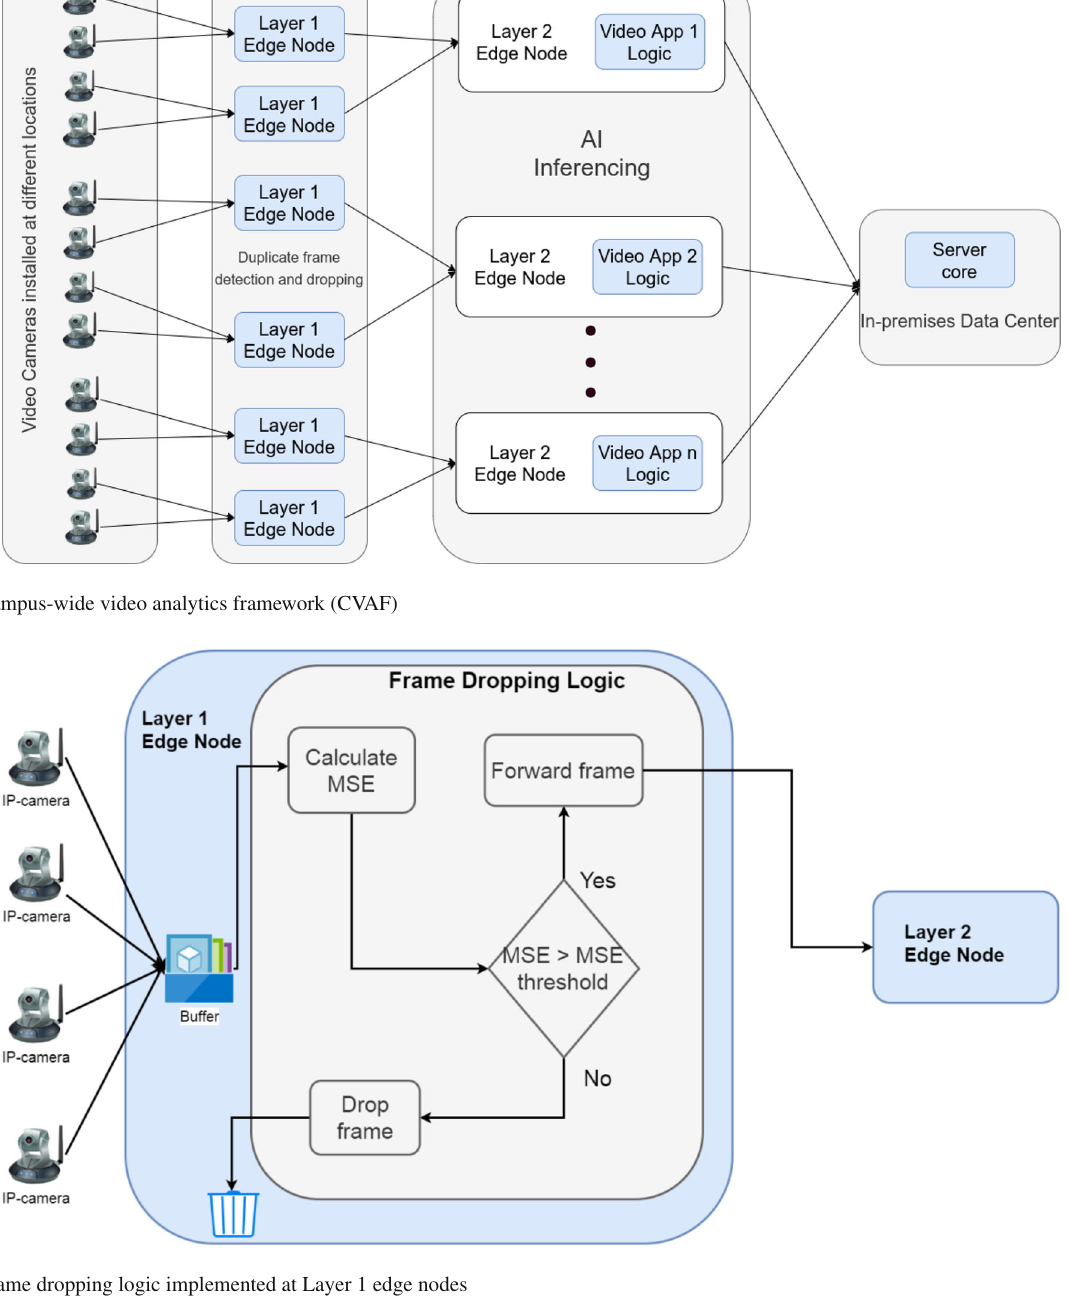
Fig. 3 Frame dropping logic implemented at Layer 1 edge